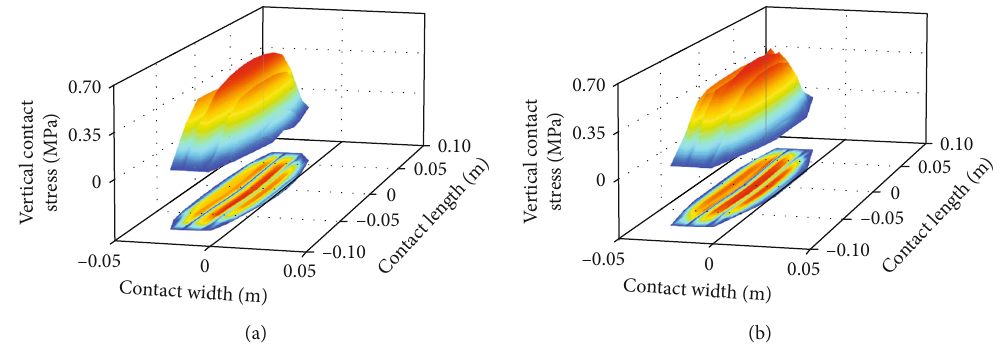
Figure 12: Contact patch and pressure distribution during steering with a 30 ° roll angle: (a) control tire; (b) bionic